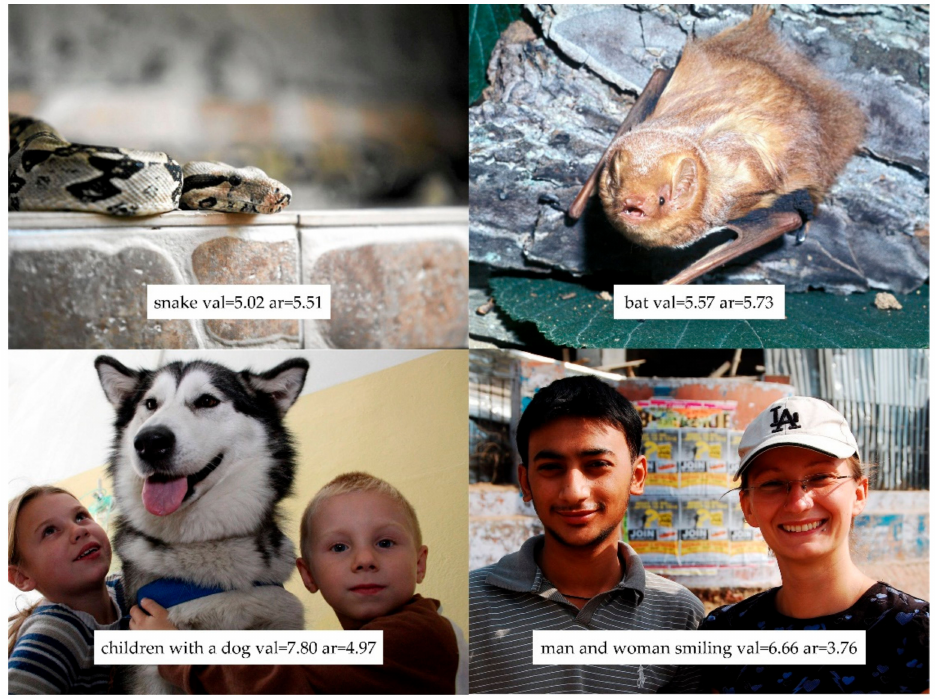
Figure 2. Example pictures from the NAPS dataset. Reproduced with permission from Marchewka, A.; ˙Zurawski, Ł.; Jednorog, K.; Grabowska, A. The Nencki Affective Picture System (NAPS): Intro- duction to a novel, standardized, wide-range, high-quality, realistic picture database (2014),